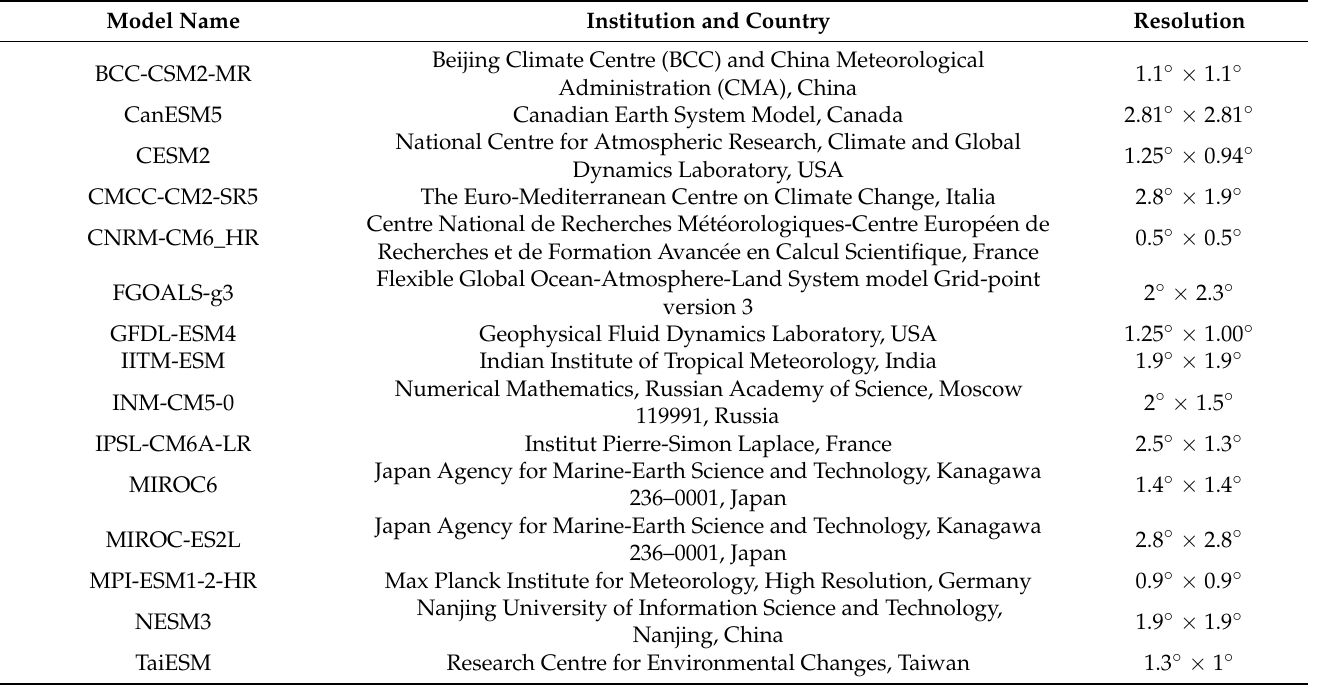
Table 1. List of the global circulation models (GCMs), i.e., biased CMIP6 models used in the